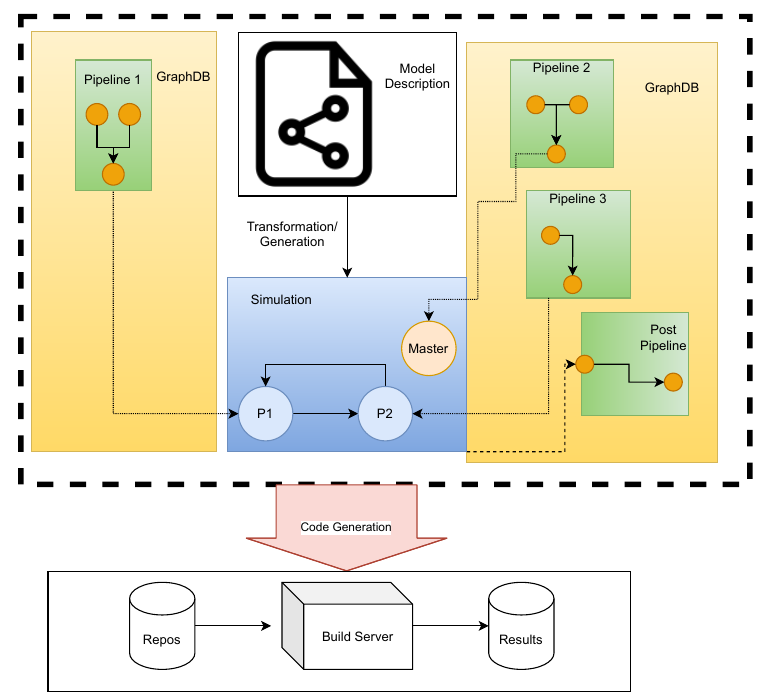
Figure 4. Pipeline graphs in a